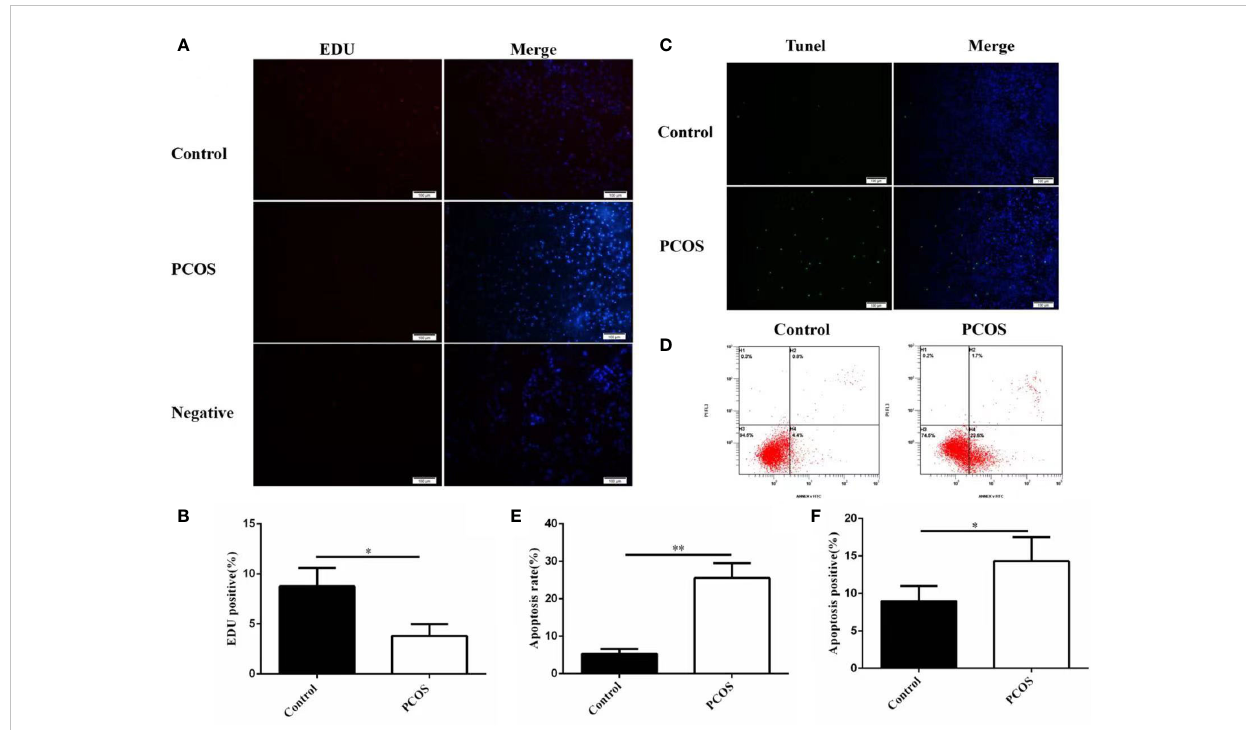
FIGURE 2 Proliferation and apoptosis of GCs from PCOS and control group. The proliferation ability of granulosa cells in PCOS group was signi fi cantly lower than that in control group (A, B) , n=5 in each group. The apoptosis level of granulosa cells in PCOS group was signi fi cantly higher than that in control group (C – F) , n=5 in each group. * P <0.05, ** P <0.01 vs Control